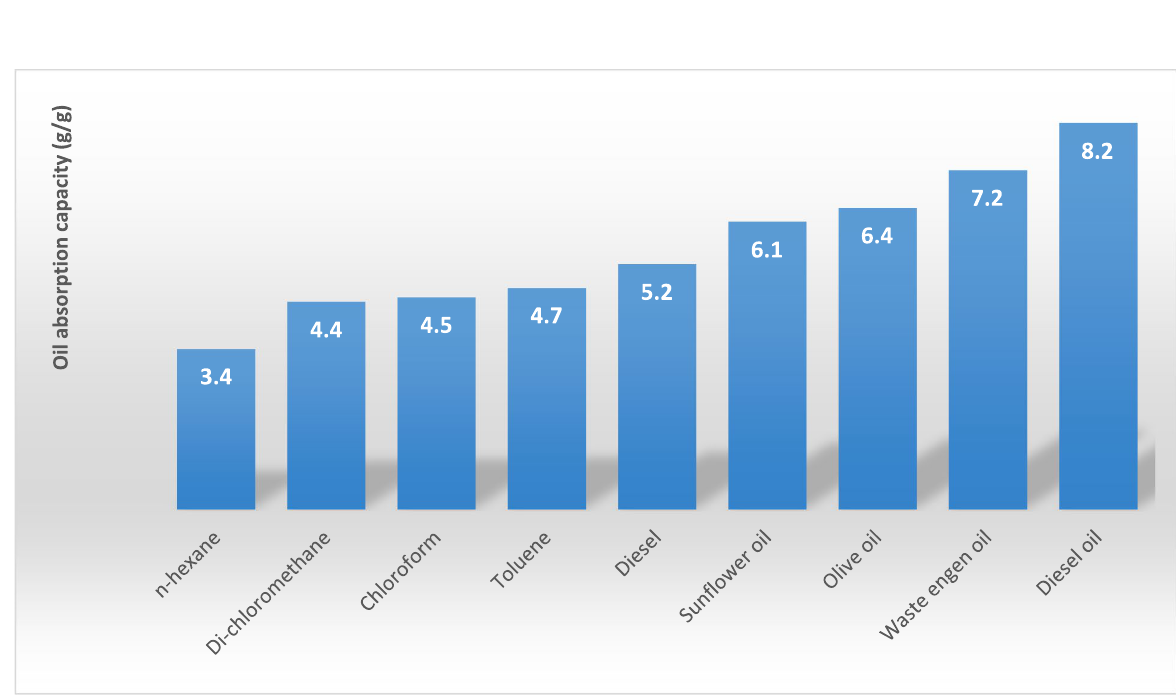
Figure 5. Absorption capacities of the modified surface of cellulosic filter papers in different oils and organic